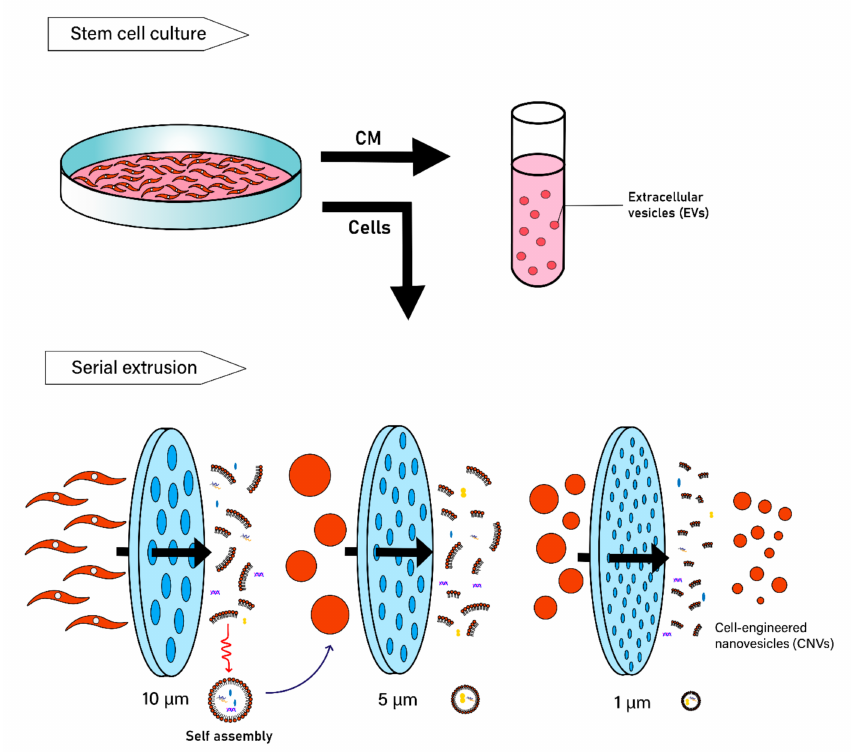
Figure 2. Approaches to generating nano-sized vesicles. Preparation of nano-sized vesicles by collection of stem cell conditioned media containing secreted exosomes or serial extrusion of cells through membrane filters. The latter forced mechanical disruption of plasma membrane method generates extracellular vesicle (EV)-mimetic nanovesicles, termed cell-engineered nanovesicles